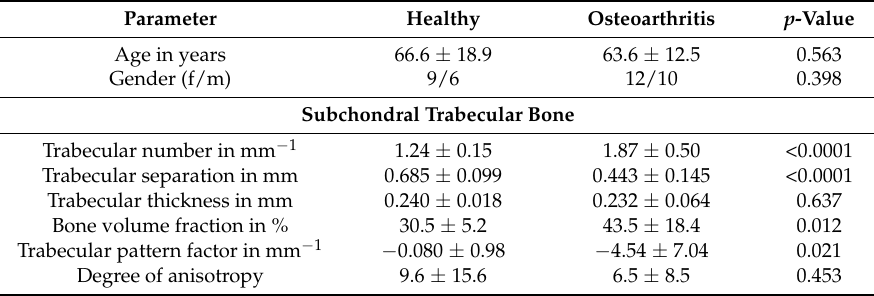
Table 1. Subchondral bone structural parameters in healthy and osteoarthritic lumbar facet